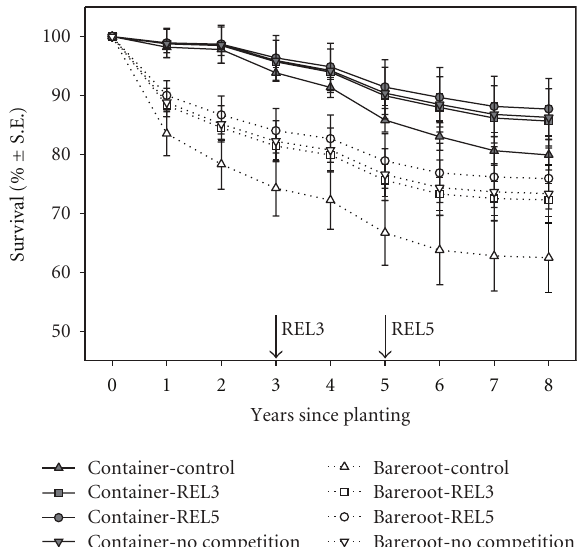
Figure 3: Seedling survival over eight growing seasons, for large containerized and bareroot Picea glauca seedlings outplanted in south central Quebec (Canada), and submitted to four intensities of vegetation management, including a control, mechanical release during the third growing season (REL3), mechanical release during the fifth growing season (REL5), and plots where competition for light was eliminated through repeated herbicide and mechanical release treatments (No competition: NC).